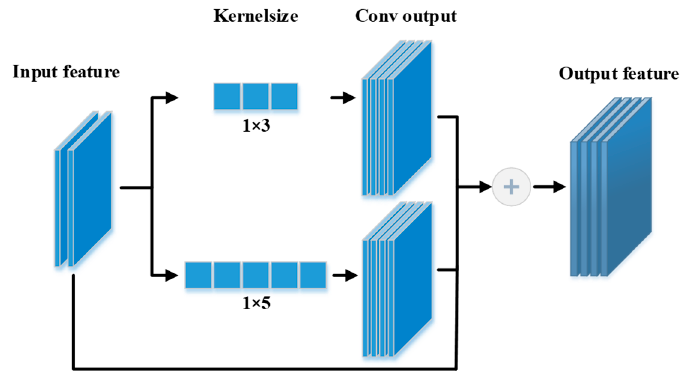
Figure 3. The structure of the spatial interaction module of multi-pedestrians.